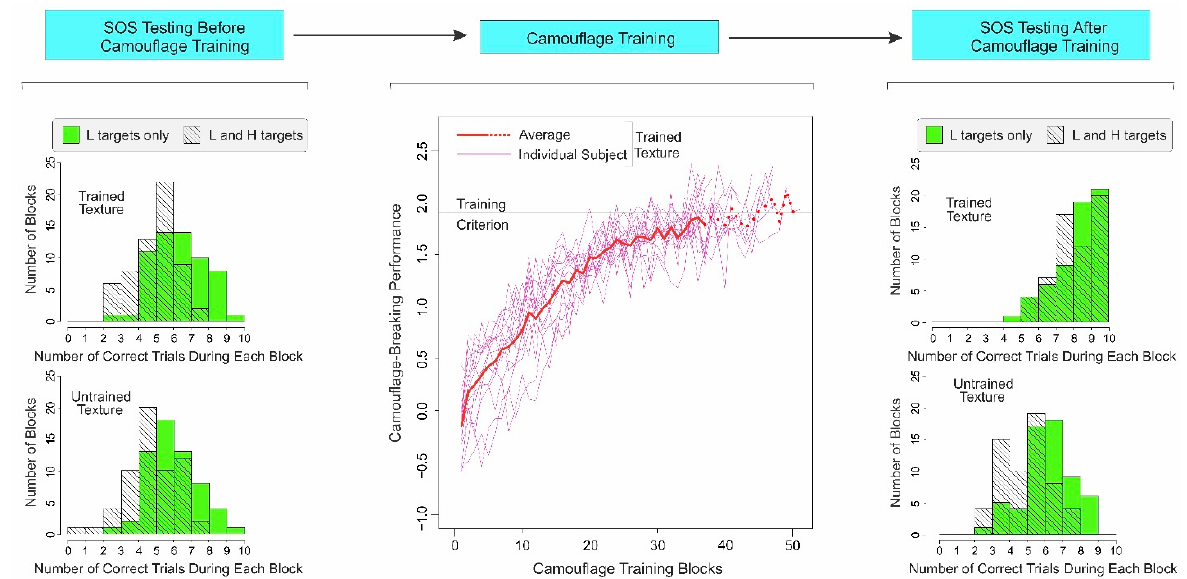
Figure 2. Results of Experiment 1. The temporal order of the three main phases of the experiment is schematically shown at the top. The results of SOS testing before and after camouflage training are shown in histogram form in the far left and far right columns, respectively. In either column, the top and bottom histograms show SOS data for the trained and untrained textures , respectively. Each histogram shows SOS as the comparison between the correct responses during the L-only trials ( green histogram ) vs. correct responses during the L-and-H trials ( hatched trials ). The extent to which the average response during the L-only trials exceed the responses during the L-and-H trials is a standard measure of SOS [4]. The middle panel of the figure shows the camouflage-breaking performance (as measured by d’ ) during successive blocks of camouflage training for individual subjects ( thin pink lines ; see inset ) and the subject sample as a whole ( thick red line ). Note that some subjects reached criterion ( horizontal black line ) with fewer training blocks, so the effective sample size decreased during subsequent blocks, a fact denoted by the thick dotted line. See text for additional details.